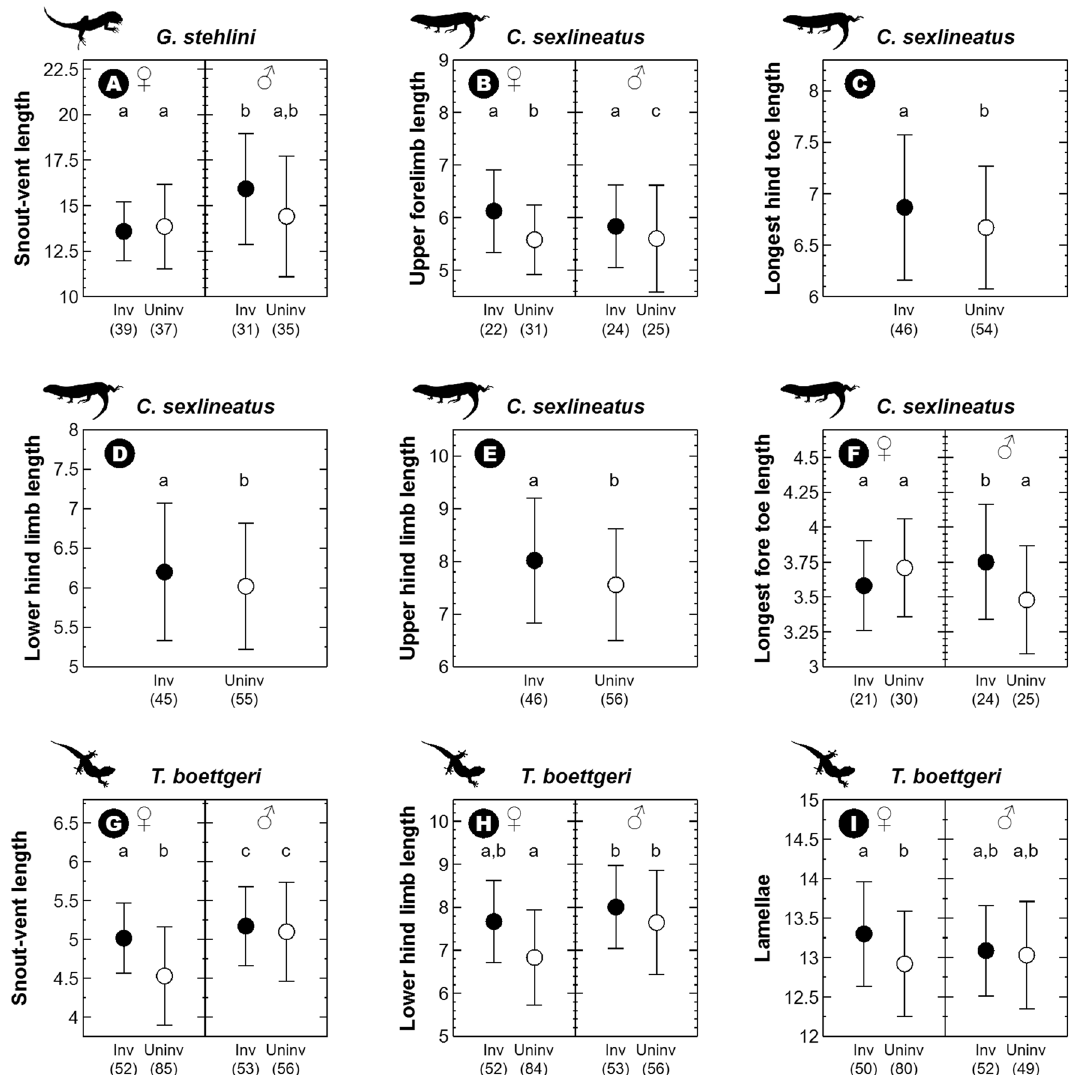
Figure 3. Mean and SD of the morphological traits of adult females ( ♀ ) and males ( ♂ ) of Gran Canaria giant lizards ( Gallotia stehlini ) ( A ), Gran Canaria skinks ( Chalcides sexlineatus ) ( B – F ) and Boettger’s wall geckos ( Tarentola boettgeri ) ( G – I ), that presented significant differences between sites invaded (inv; black) and uninvaded (uninv; white) by the California kingsnake ( Lampropeltis californiae ). Sample size for each trait—i.e., number of individuals captured for which each trait was measured, excluding values attributed to observer error—is indicated between parentheses below each figure. Significant differences are signaled with different letters. All morphological measurements are in mm, except the SVL (cm) and the number of toepad lamellae (no. lamellae). All silhouettes come from phylopic.org or the free repository of the Government of the Canary